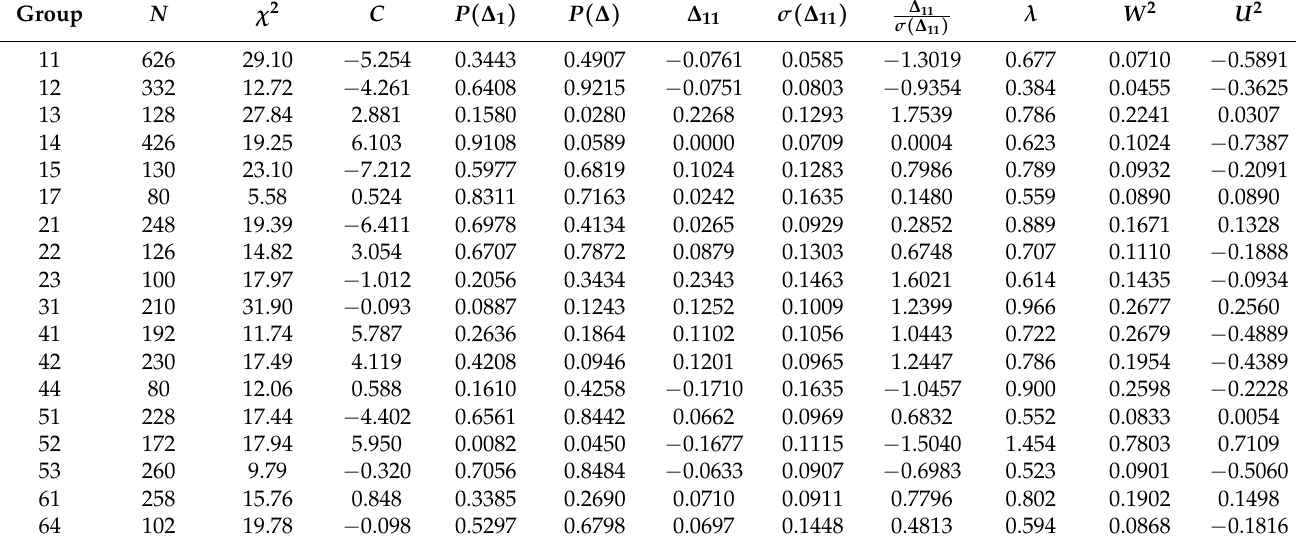
Table 13. Test for isotropy of the orientations of the galaxy plane. The distribution of the angle δ D was calculated with q 0 depending on the morphological type and Fouque and Paturel correction.